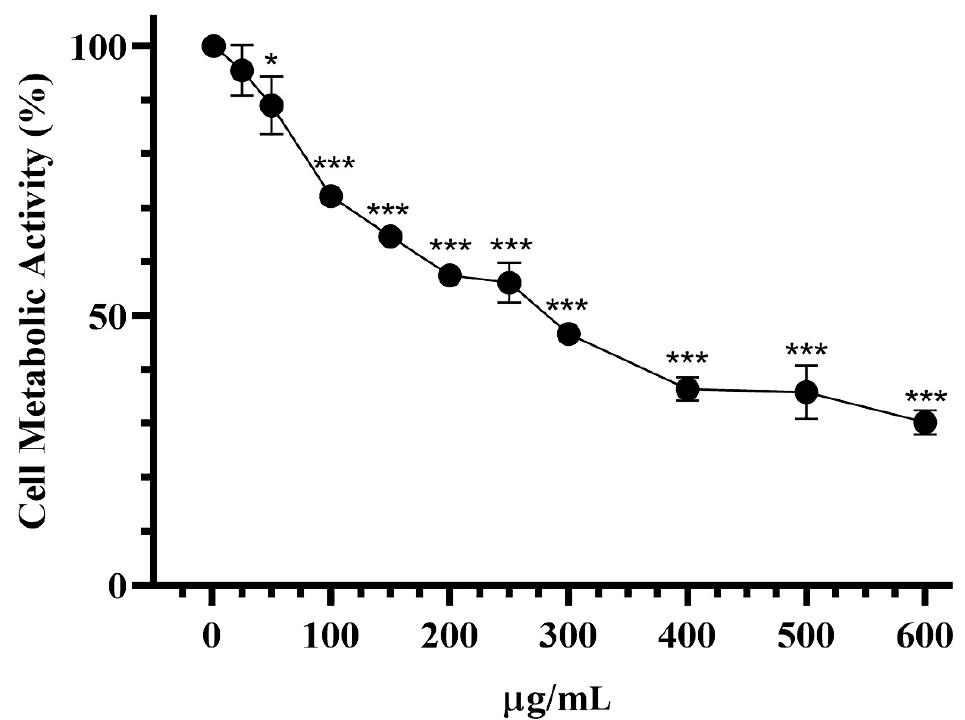
Figure 4. Influence of quince purified extract on 3T3-L1 cell metabolic activity determined by the PrestoBlue HS assay after 48 h exposure to the extract; control cells were not exposed to any compound; values are means ± standard deviations from at least three independent experiments, n ≥ 12; statistical significance was calculated versus control cells (untreated), * p ≤ 0.05, *** p ≤ 0.001.